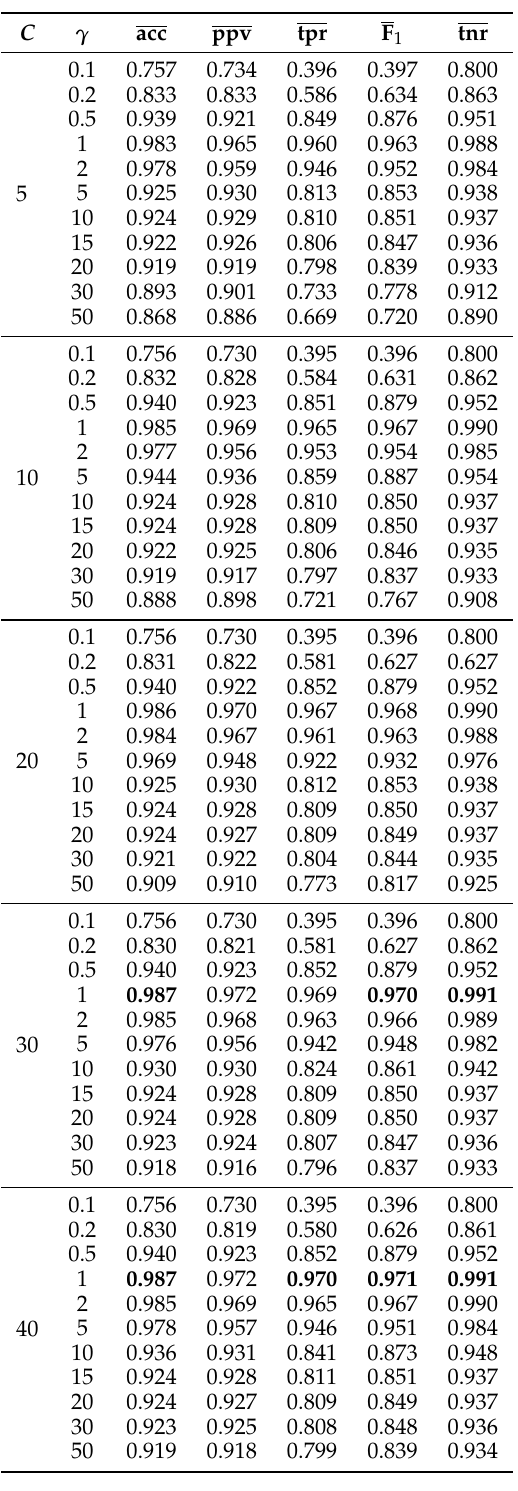
Table 8. Performance measures (per-unit) corresponding to the Gaussian SVM strategy for the multiclass classification problem using different box constraints ( C ) and different kernel scales ( γ ). The cases with the best performance of each measure are highlighted in